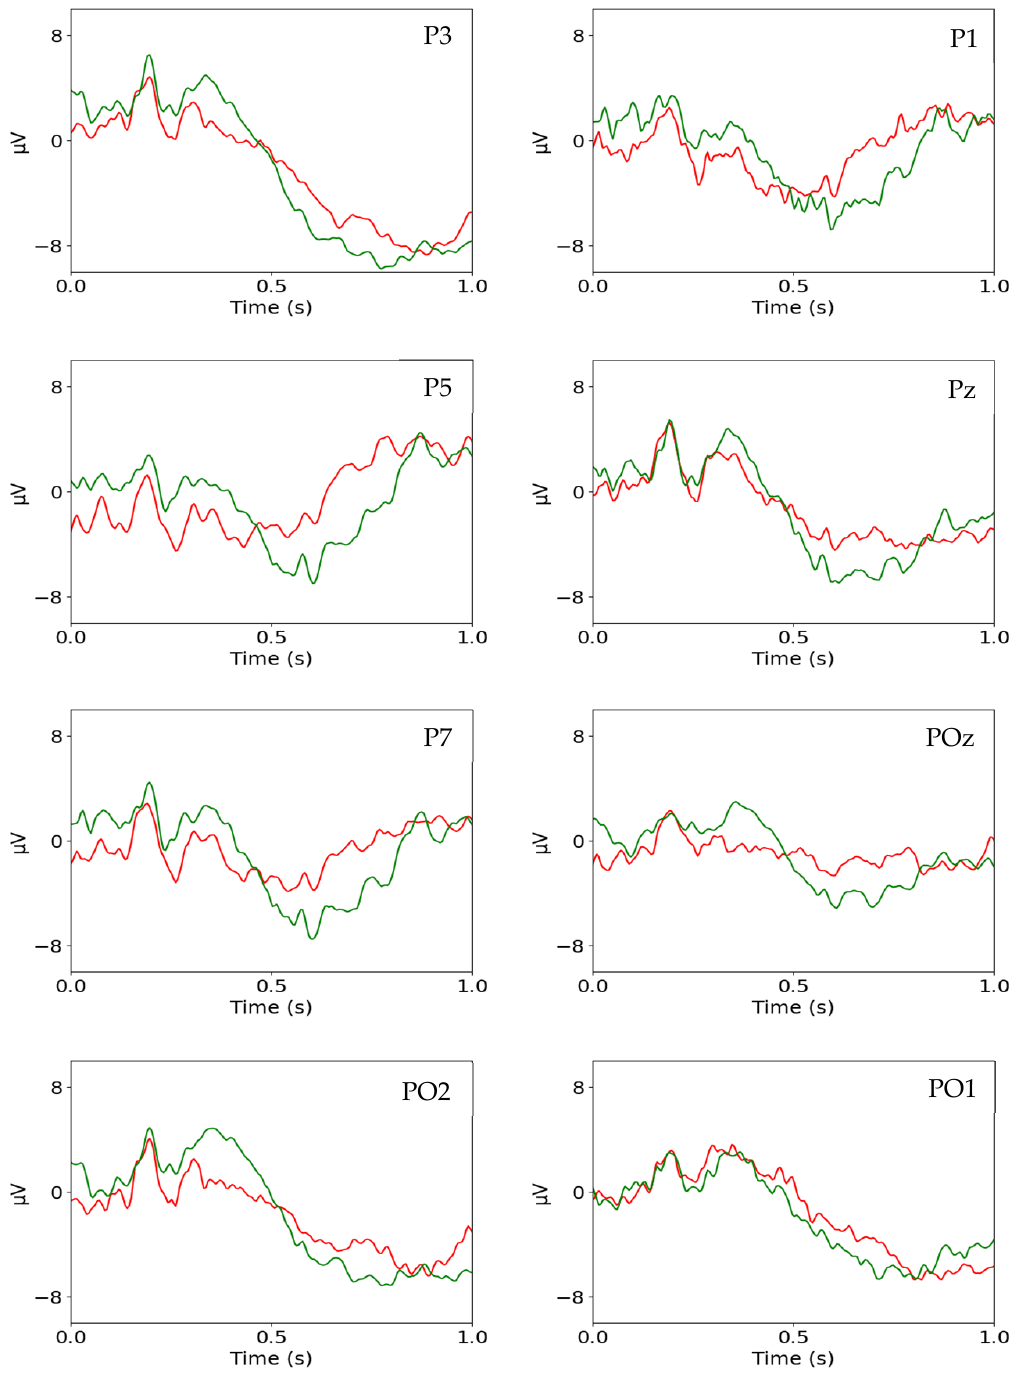
Figure 2. The full-sample synonymous (green) and non-synonymous (red) Ω -ERPs of the 8 selected channels of subject b 1